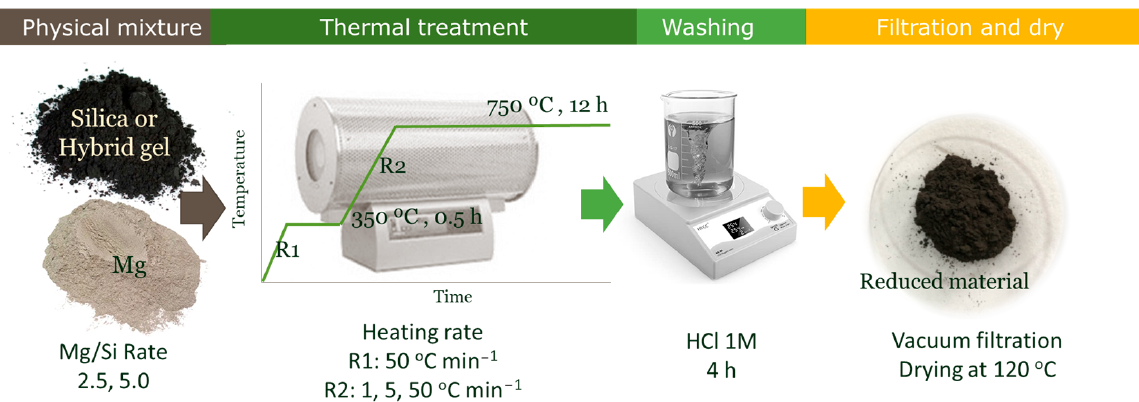
Figure 1. Schematic representation of the magnesiothermal process.